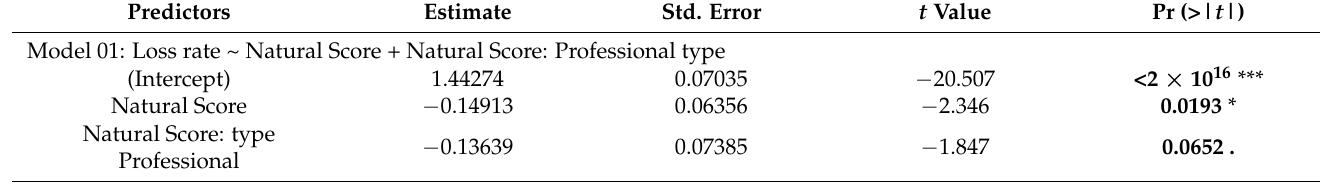
Table 2. Results of the generalized linear models, which were performed to test the effect of natural habitat usage (Model 01) and acaricide treatment (Model 02) on colony losses.